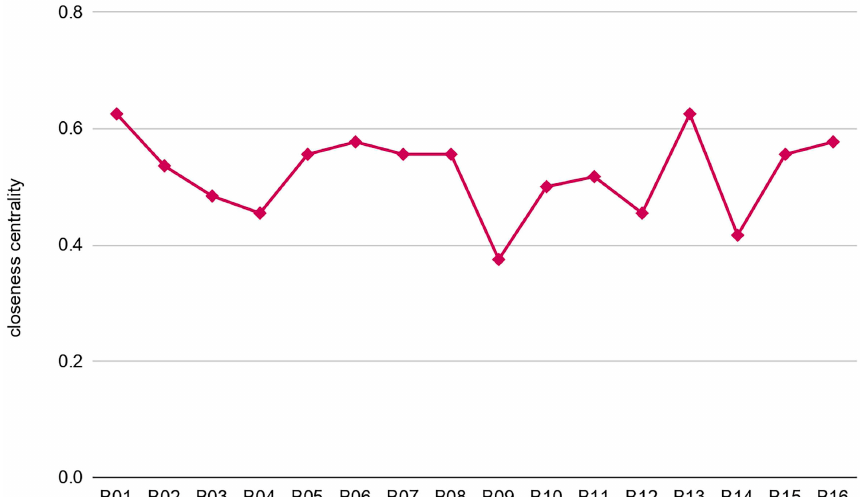
Figure 9. Closeness Centrality Analysis of Barriers.